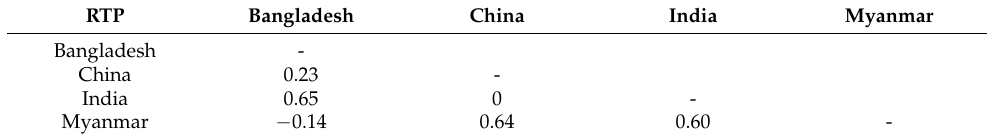
Table 6. RTP index for countries in the Bangladesh–China–India–Myanmar Economic Corridor (BCIMEC).